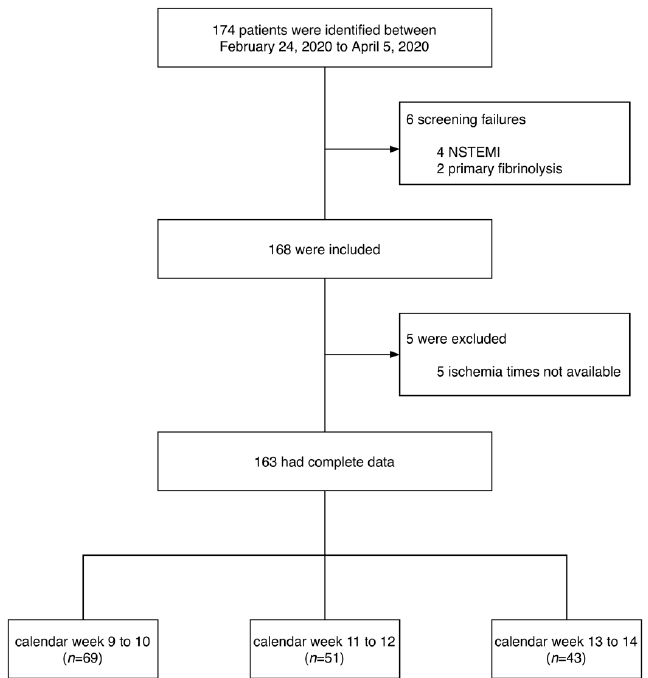
Figure 1. Flow chart of the study. NSTEMI = non-ST-elevation myocardial infarction. Table 1. Patient characteristics of the overall study population.